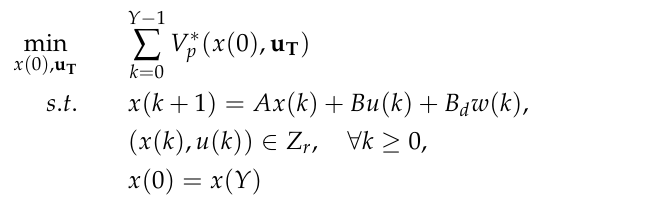
Figure 5. Soil water content as a function of time for nonlinear and linearized models in the first four soil layers. The main goal of this control structure consists of managing the irrigation to achieve optimal economic performance, which optimizes the cost function, reducing the irrigation depth and the costs associated with the water and energy. This performance cost func- tion V ∗ is used by a real-time optimization (RTO) layer to provide an optimal trajectory. p The optimal trajectory to operate the system is derived from the solution of the following optimization problem(6a), (6b), (6c) and (6d) where the initial state is a free